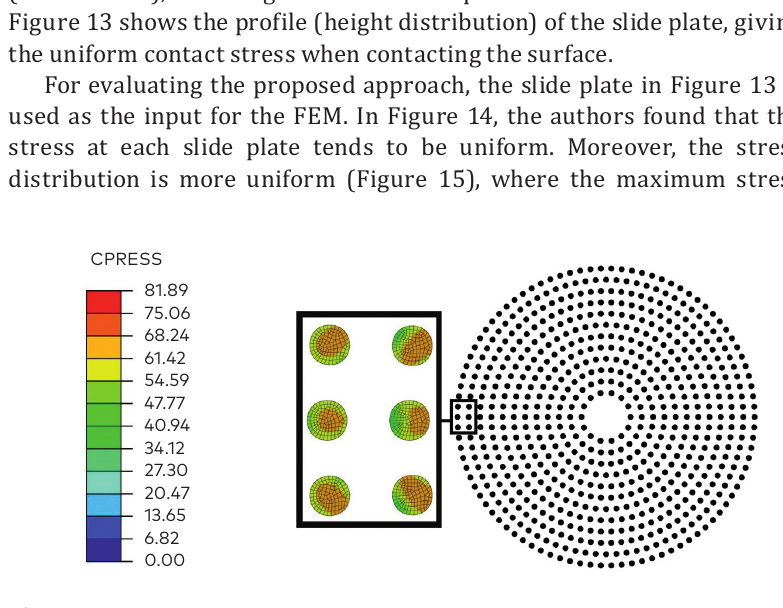
Figure 15. Stress distribution of the rotating mechanism with slide plates after the optimal